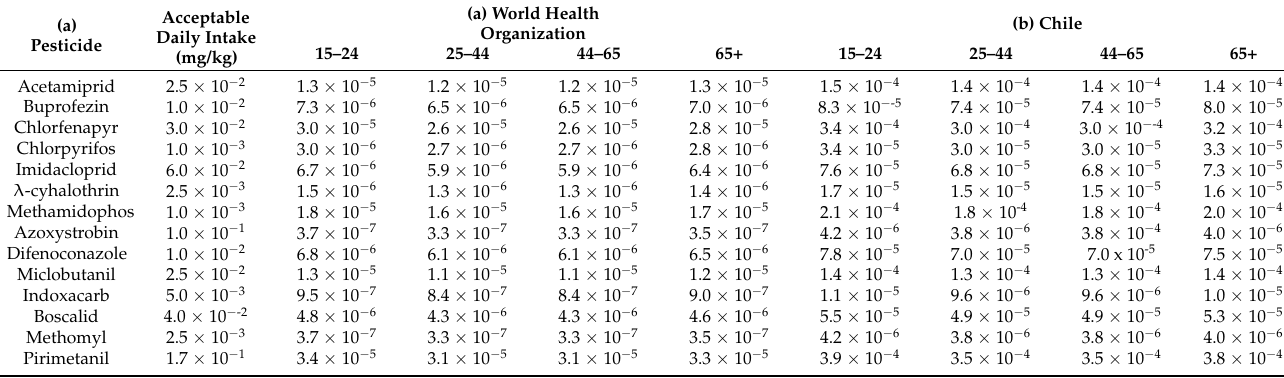
I—Insecticide, F—Fungicide. Estimated Daily Intake (mg/kg bw/d) for different gender, age groups, national and international scenarios: (a) Men; (b)